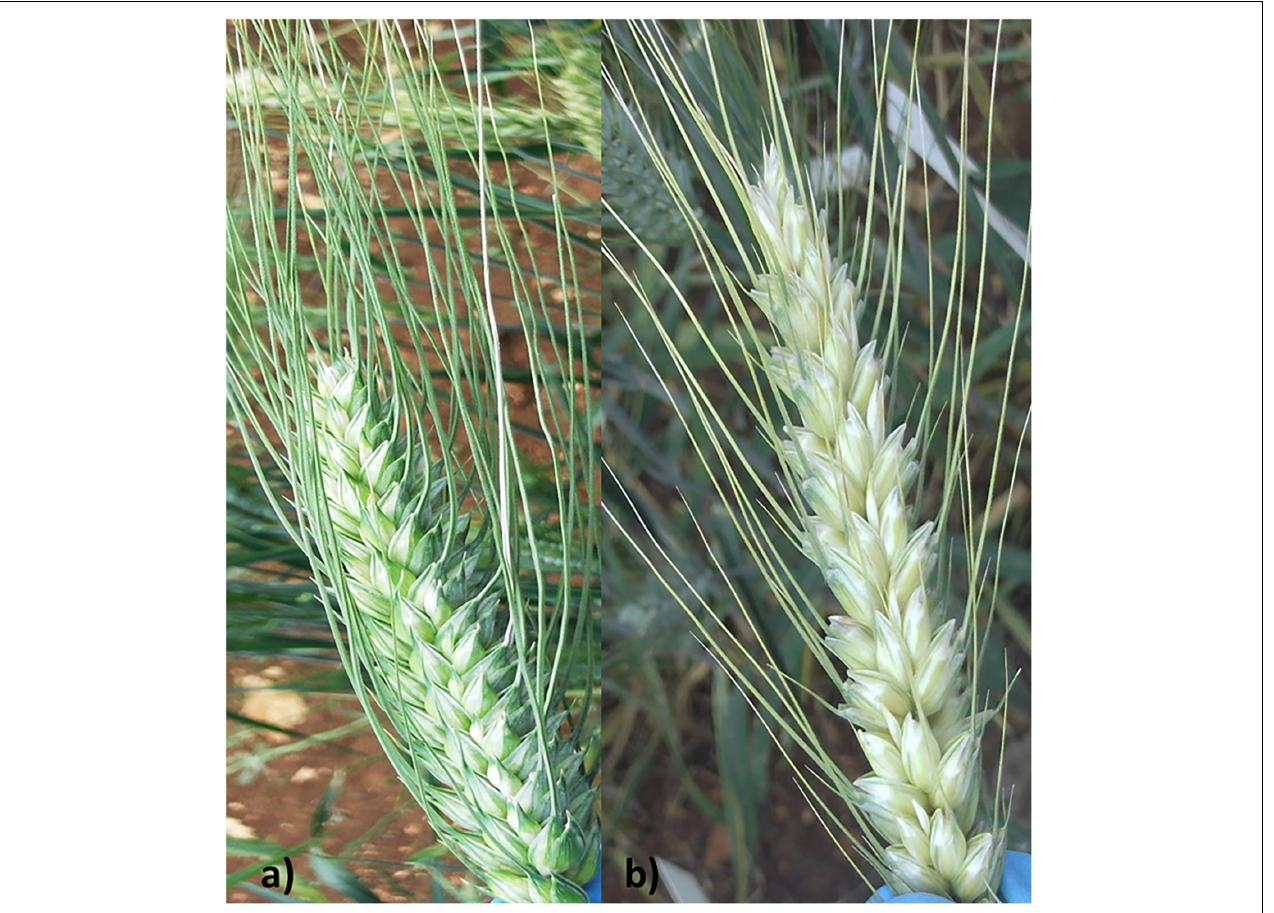
FIGURE 1 | Spike morphology of FHB-susceptible durum wheat cv. Saragolla (a) and FHB-resistant hexaploid wheat line 02-5B-318